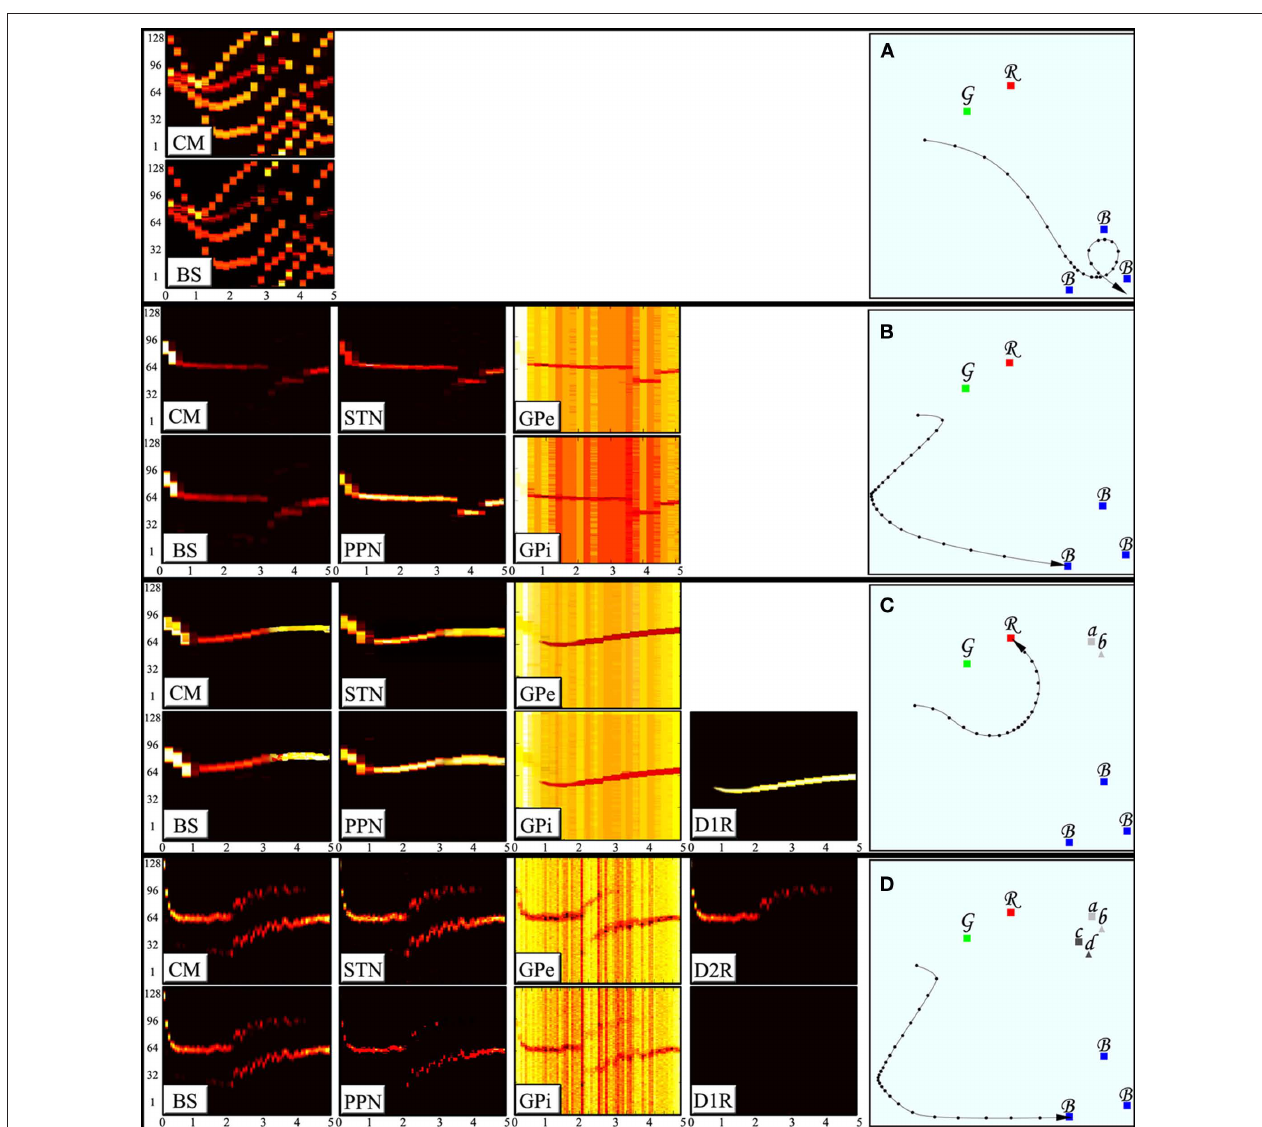
deprived of effective escape and precise targeting behaviors. (B) An animal with arbitration system is capable of selecting one action and suppress all of its competitors hence enhancing the escape and targeting behaviors. (C) An animal with D1RN connections to the GPe and the GPi can enforce learned responses and suppress the otherwise strongest action in certain states. (D) An animal with D2RN collaterals can suppress the learned responses in certain